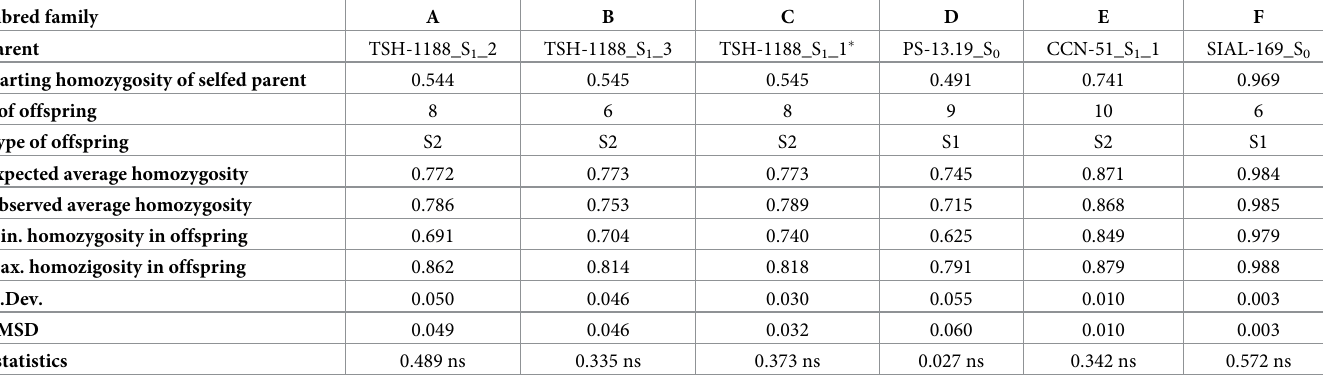
Table 2. Summary of results of homozygosity of the six inbred cacao families produced by self-fertilization of cacao clones TSH-1188, PS-13.19, CCN-51 and SIAL- 169. RMSD: root-mean-square-deviation between the observed and Mendelian model expected homozygosity; t-test of the null hypothesis of no difference between the family mean observed and expected numbers of homozygous SNP